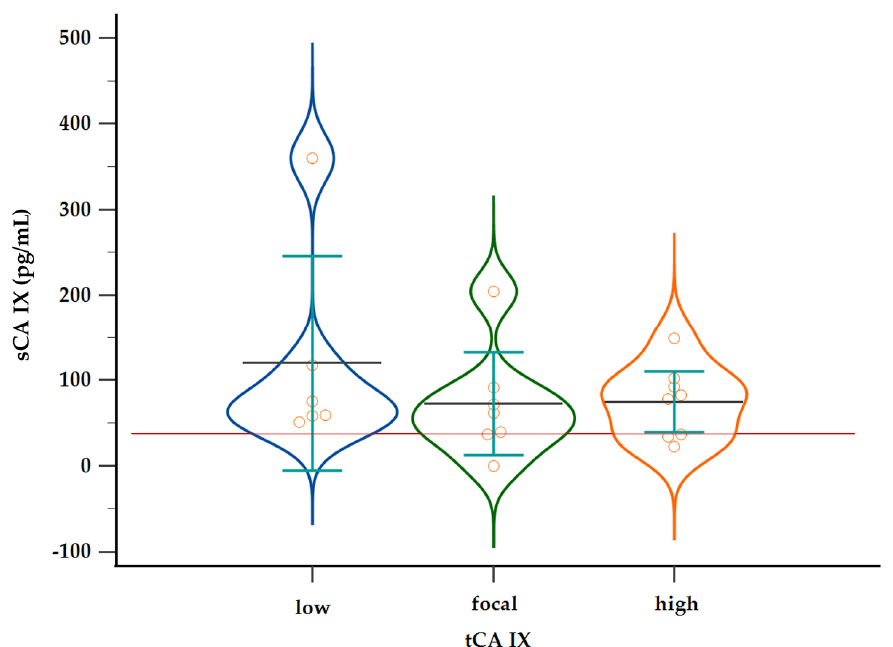
Figure A11. Analysis of sCA IX levels in the plasma of patients with the CA IX+ tumor tissue using R&D ELISA. Violin graphs with dots (plot all data) showing sCA IX levels of patients divided based on CA IX score into groups: low, focal, and high tCA IX. Cut off value, 37.8 pg/mL, is shown as red horizontal line. Differences between groups were assessed by Kruskal–Wallis test with Dunn’s post hoc test with the result p = 0.7221 .